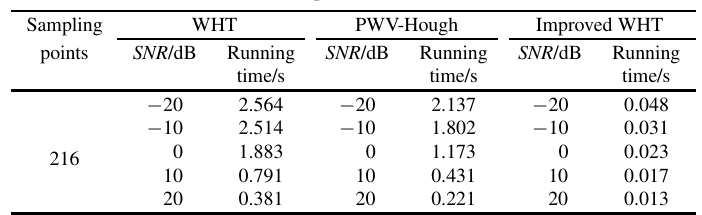
Table 1 Run-time comparison of three methods